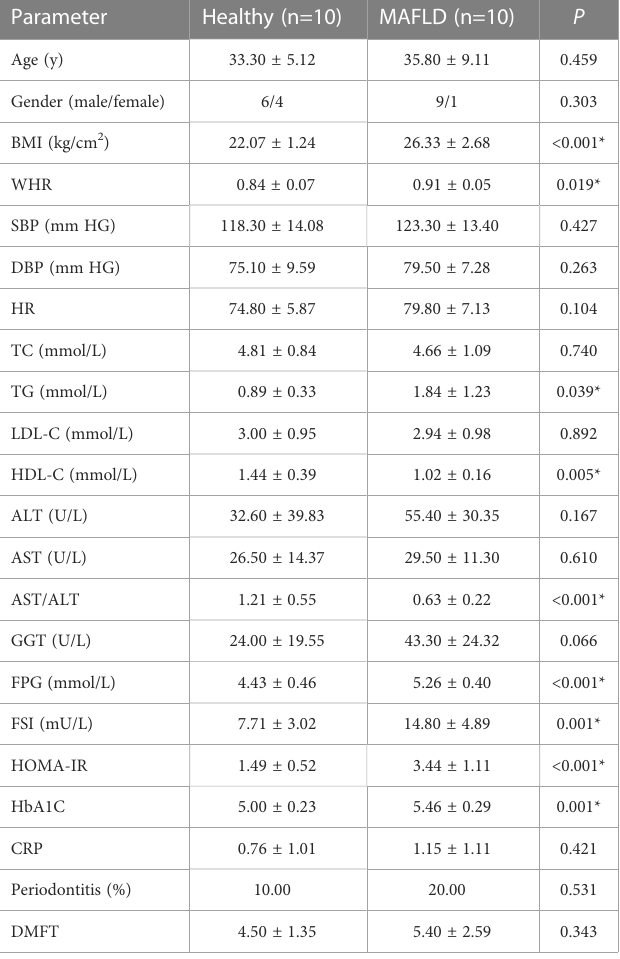
TABLE 1 Demographic and clinical characteristics of the study population.